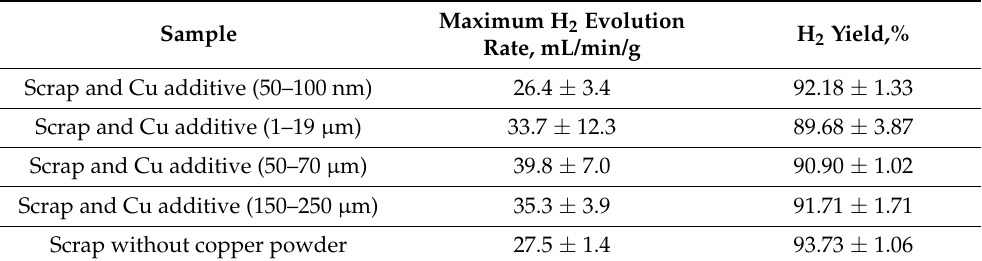
Figure 5. Hydrogen yield kinetic curves for the samples with different copper powder sizes and one ball milled without copper. For all samples, their total hydrogen yields achieved close values falling within the range ~90–94%. The missing hydrogen was attributed to the abovementioned partial oxidation of Al during ball milling. Table 1. Hydrogen production yields and rates for different samples.